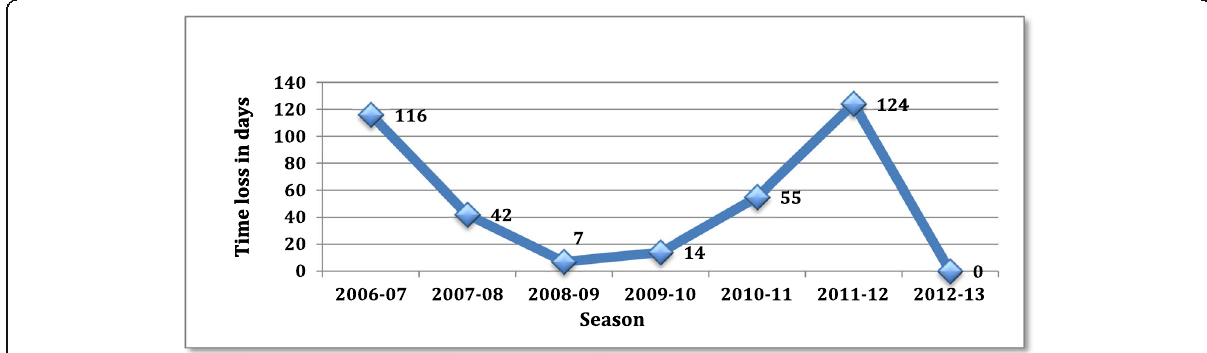
Fig. 9 Time loss in days depending adductors and abdominal